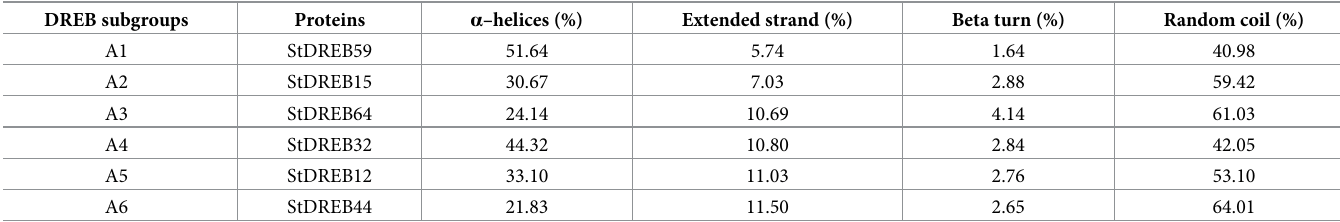
Table 2. Secondary structure analysis of StDREB proteins using SOPMA server. DREB